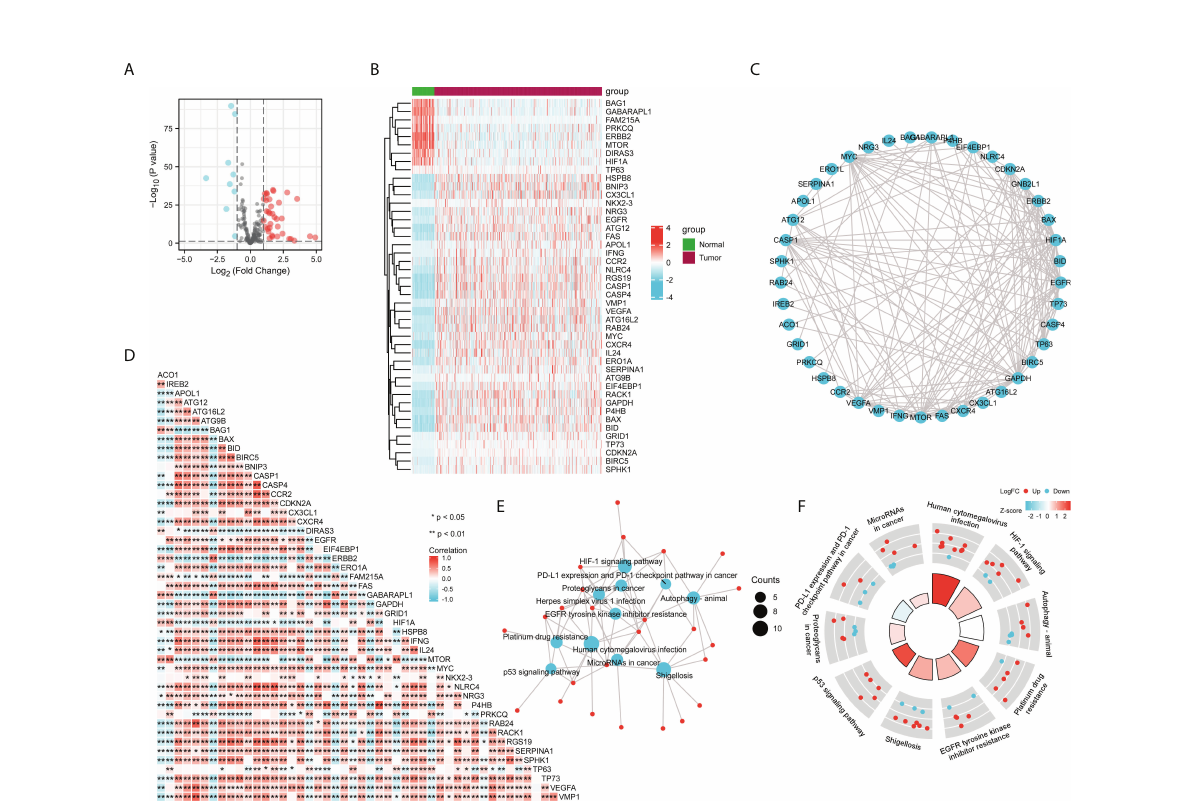
FIGURE 7 Correlation analysis of ACO1, REB2 expression with autophagy-related genes in TCGA-KIRC database. (A, B) Volcano plots (A) and heat maps (B) showing the 45 differentially expressed autophagy-related genes in TCGA-KIRC database compared with normal controls. (C) A heat map shows the correlations between ACO1, IREB2 and the 45 genes in KIRC. (D) The PPI network of ACO1, IREB2 and the 45 genes was generated using STRING. (E) The visualized network of KEGG enrichment analysis for ACO1, IREB2 and the 45 genes. (F) A circos diagram shows KEGG enrichment pathways with the z-score for ACO1, IREB2 and the 45 genes. PPI, protein – protein